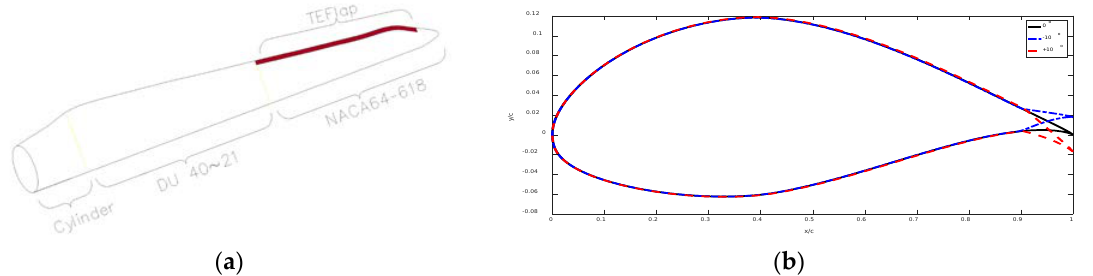
Figure 3. The TEFs configuration. ( a ) The layout of TEFs; ( b ) The airfoil profile of TEFs deflection angles at ±10°.